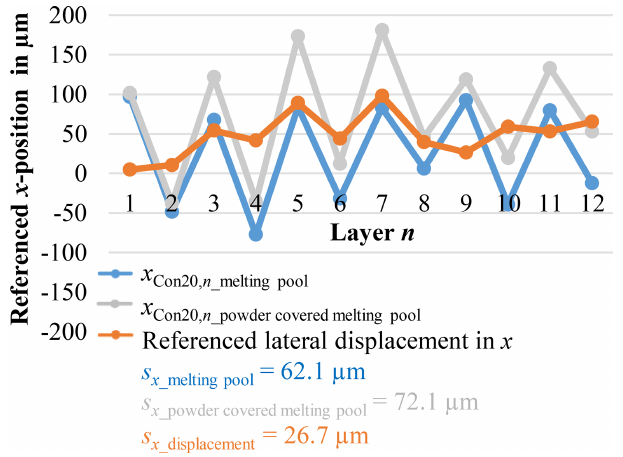
Figure 13. Evaluation of lateral displacement in x by comparison of melting pool and powder-covered contour positions (Con 20 ).